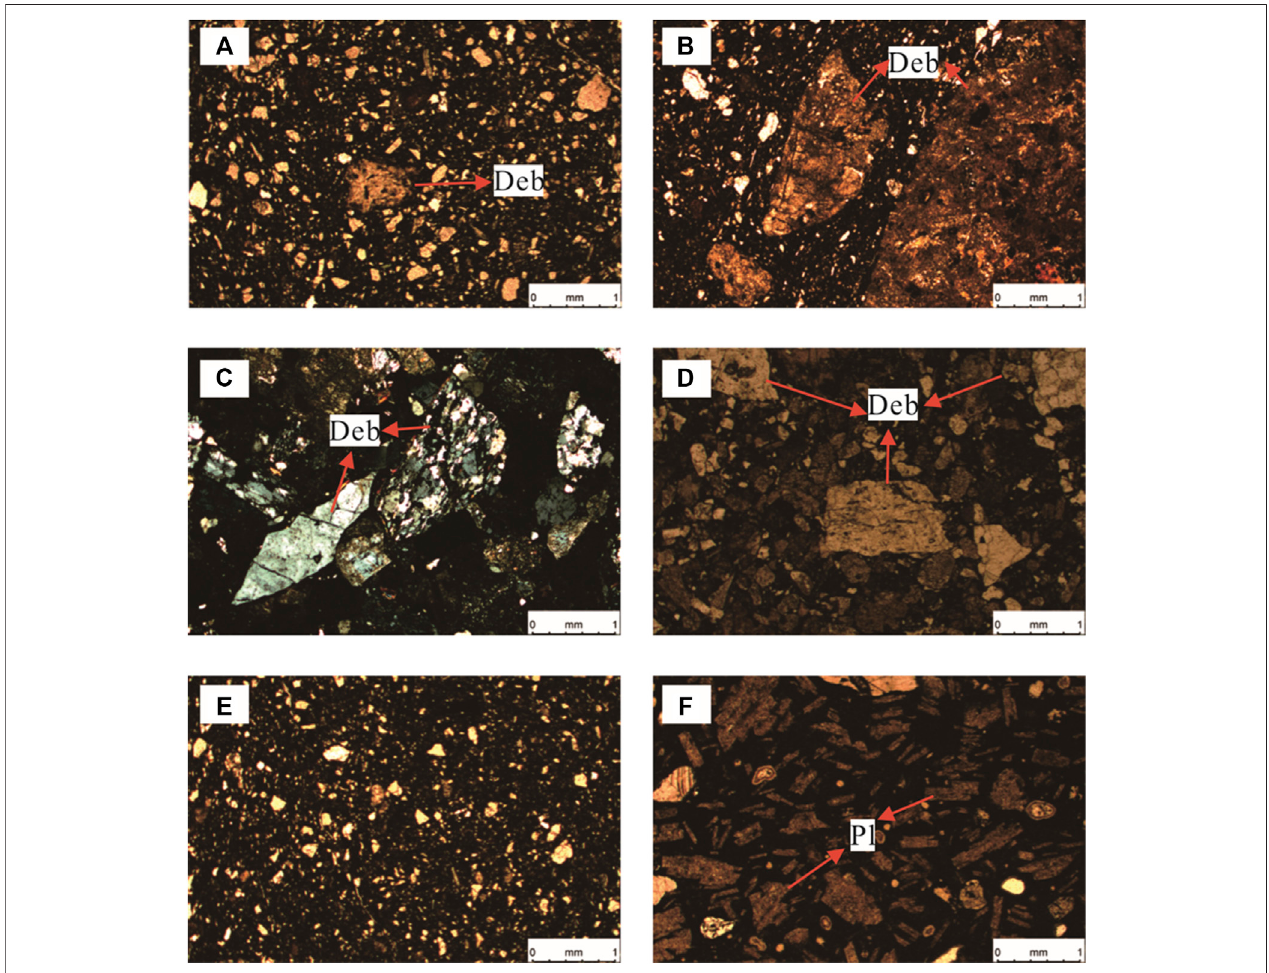
FIGURE 4 | Typical microscopic features of the Laohuzui section. (A) Microscopic characteristics of the lower sample of the olistolite (c1 – 2) (plane-polarized light). (B) Microscopic characteristics of hybrid sediment samples (C2) (plane-polarized light). (C) Microscopic characteristics of gravel samples from the olistolite (C7) (cross- polarized light). (D) Microscopic characteristics of sandstone block samples (C4) (plane-polarized light). (E) Microscopic characteristics of the upper sample of the olistolite (C5) (plane-polarized light). (F) Microscopic characteristics of igneous gravel samples (A12) (plane-polarized light). Deb: debris, Pl: plagioclase.